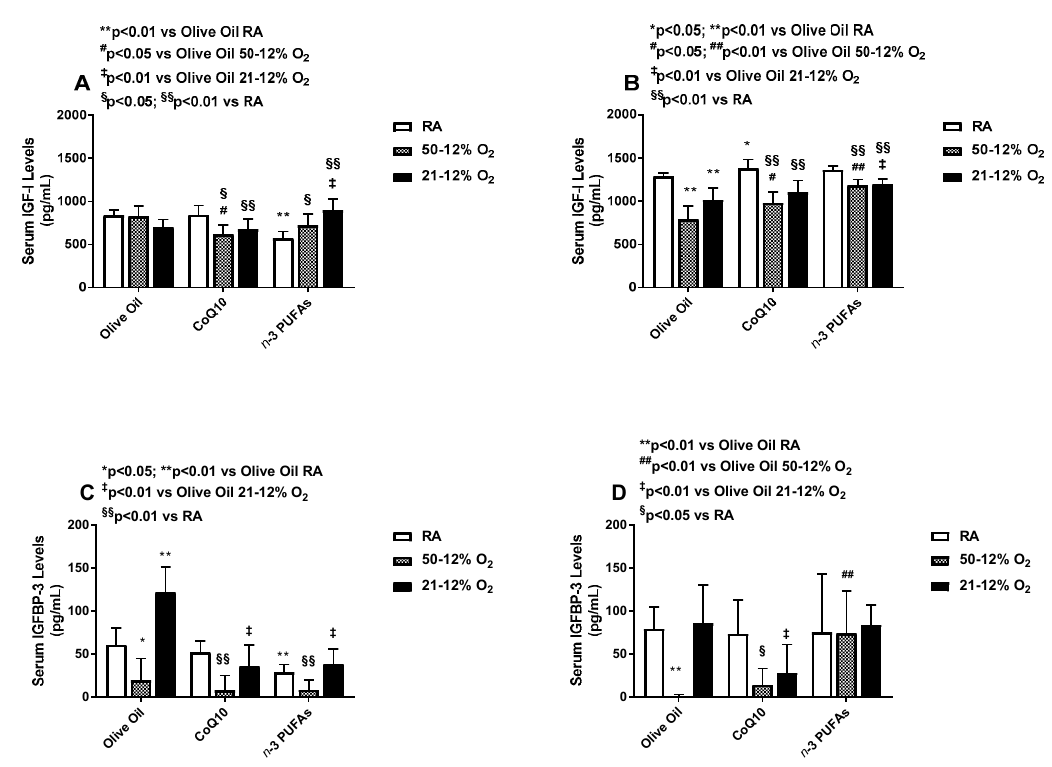
Figure 4. Effects of neonatal IH with Co-Q10 or n -3 PUFA supplementation on serum insulin-like growth factor-I panels ( A , B ) and insulin-like growth factor binding protein-3 panels ( C , D ) levels. Groups are as described in Figure 2. Data are expressed as mean ± SD ( n = 8 samples/group).